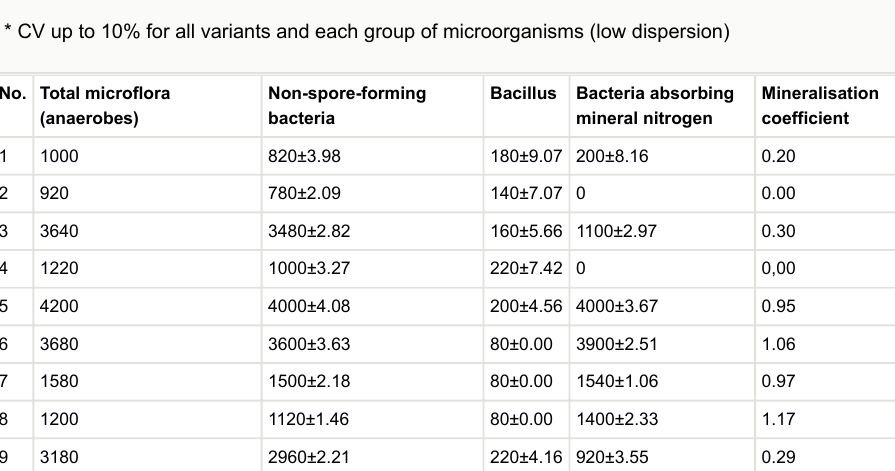
Table 3. Quantity and qualitative composition of anaerobic soil microorganisms (CFU x 10/g abs. dry soil);